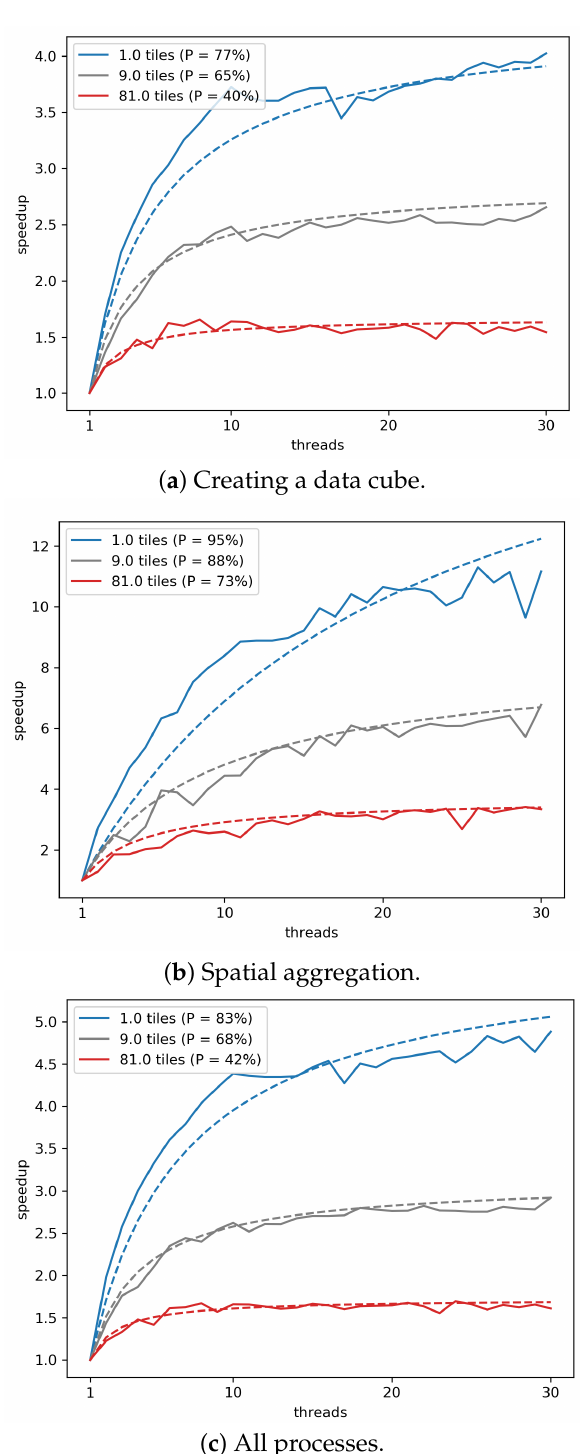
Figure 5. Experimental (solid) and (theoretical) speedup via multi-threading for different processes and tiling schemes: creating data cube ( a ), spatial aggregation ( b ), and all processes combined ( c ). Speedup increases for larger and fewer